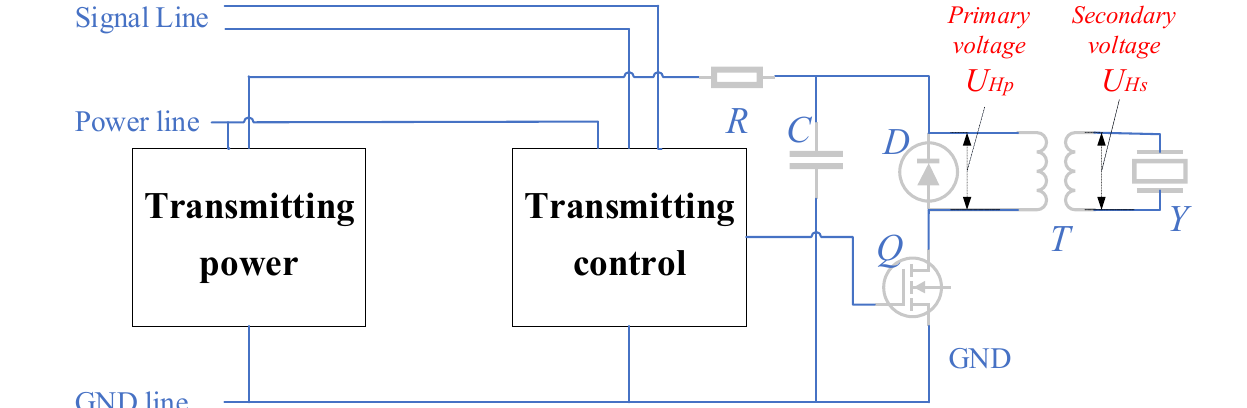
Figure 2. Working principle of the transmitting acoustic system.